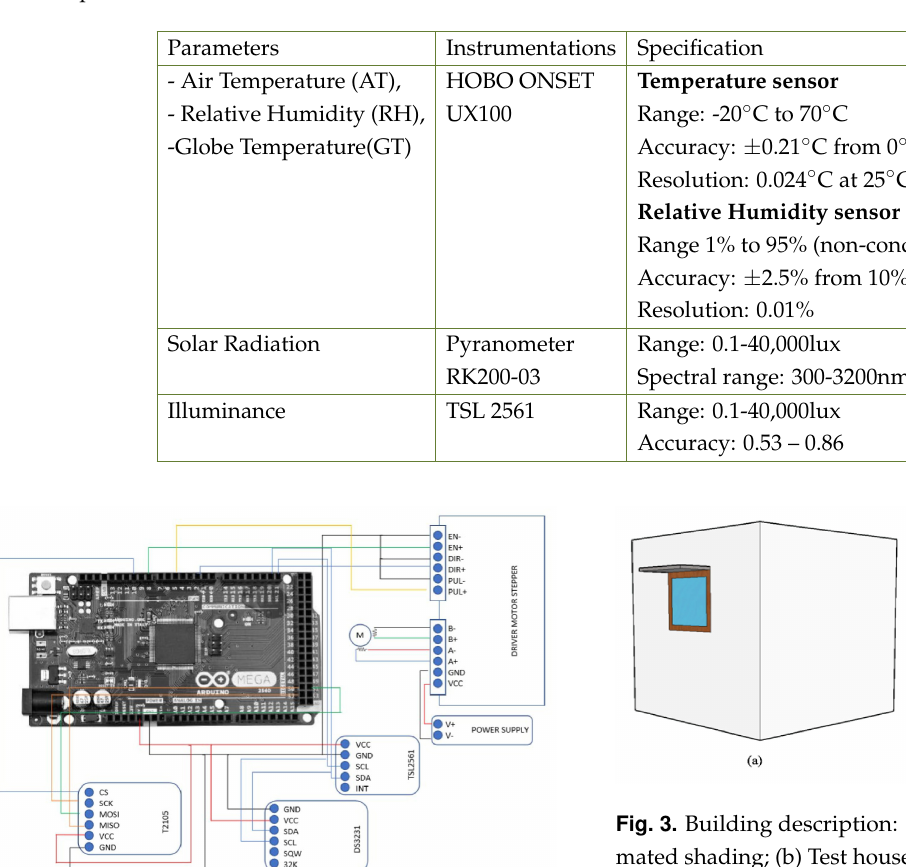
Table 2. Specifications of measurement instruments.